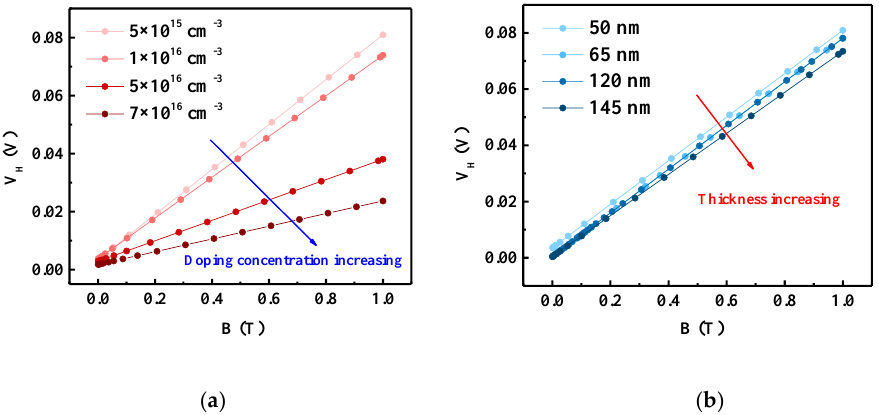
Figure 4. Hall voltage ( V H ) versus magnetic induction ( B ) simulated for sensors with di ff erent ( a ) doping concentrations and ( b ) silicon film